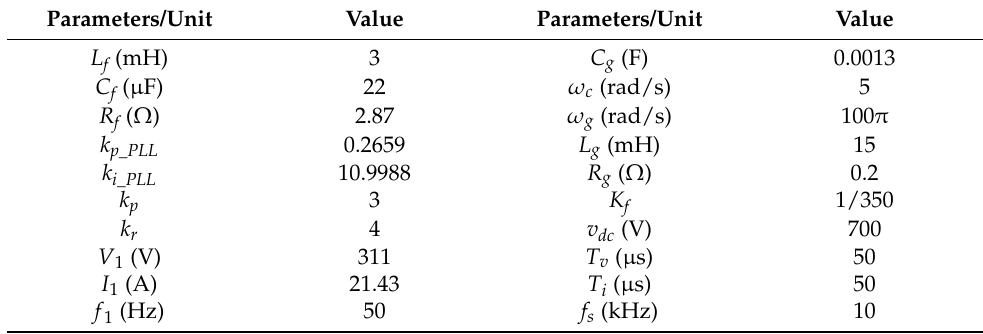
Table 1. Parameters of the grid-connected